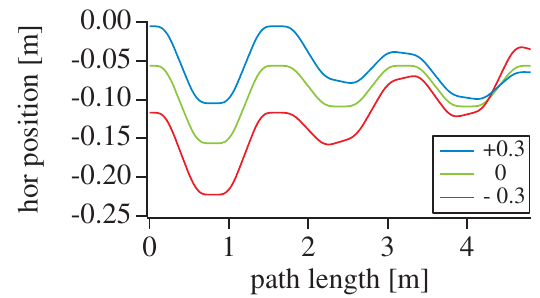
FIG. 11. (Color) (a) Horizontal and (b) vertical beta functions in a normal cell and the dispersion suppressor. Numbers in the legend show the momentum deviation from the reference mo- mentum, (cid:1) p=p . The normal cell is from 0 to 1.6 m and the dispersion suppressor section from 1.6 to 4.8